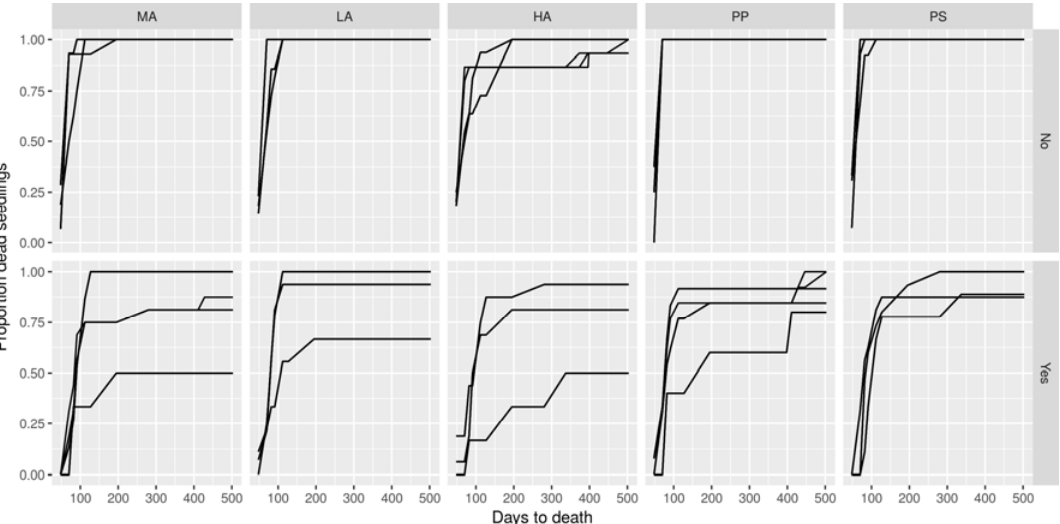
Figure 4. Observed survival pattern of the seedlings. Each line represents an experimental block. Subplots on the same row share the protection status. Subplots on the same column share seed origin (MA: P. nigra from typical distribution, HA: P. nigra from upland forests distribution, LA: P. nigra from lowland forests distribution, PS: P. sylvestris and PP: P. pinaster ).